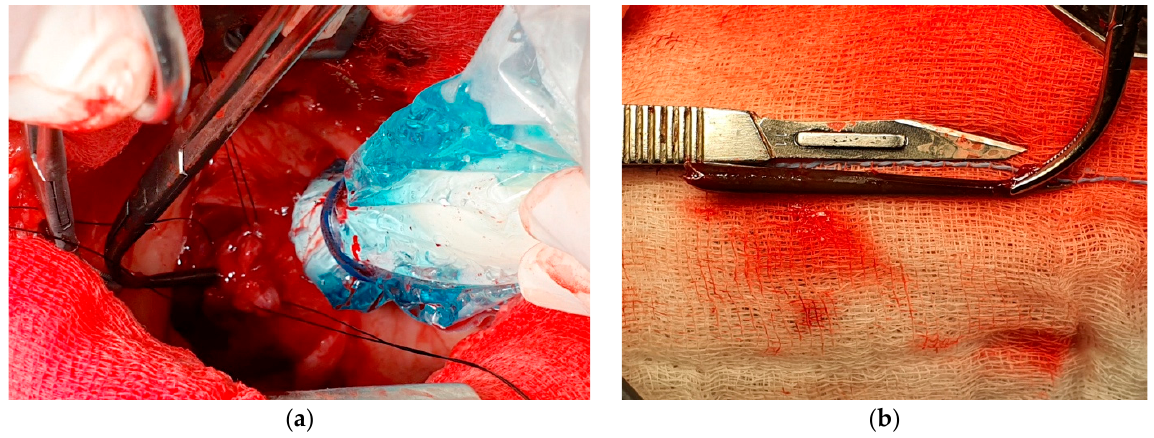
Figure 5. Intraoperative images of the surgical removal of the porcupine quill through median sternotomy. ( a ) Ultrasound-guided removal of the porcupine quill by a curved hemostat from a small incision on the cardiac apex; ( b ) the porcupine quill after the removal.